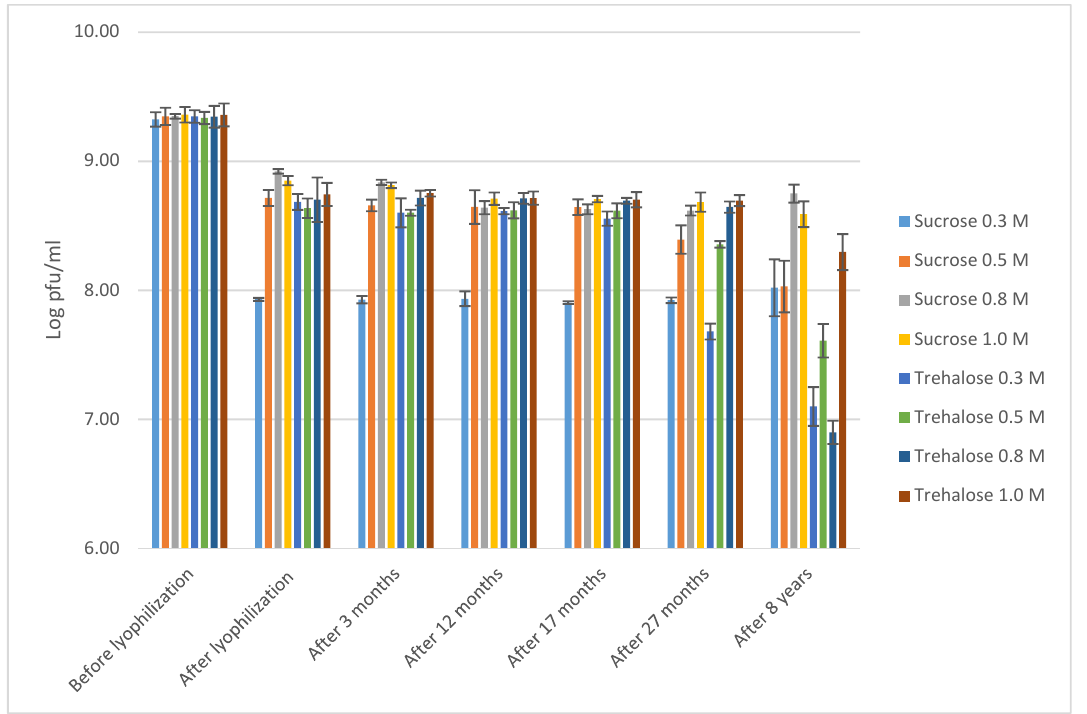
Figure 2. Stability over time of the infectivity of phage ISP, lyophilized at 9 log pfu/mL, in two different stabilizers (sucrose and trehalose) at four different concentrations (0.3 M, 0.5 M, 0.8 M and 1.0 M) and stored at 4 °C, the last samples are rehydrated from an 8 year old lyophilized sample in saline and stored at 4 °C for 126 days. Data till 27 months are reproduced from Merabishvili et al. [2]. The results are the mean values of triplicate samples for all samples, except the 8 year old samples, for which three titrations performed done on single samples. Standard deviations are indicated.